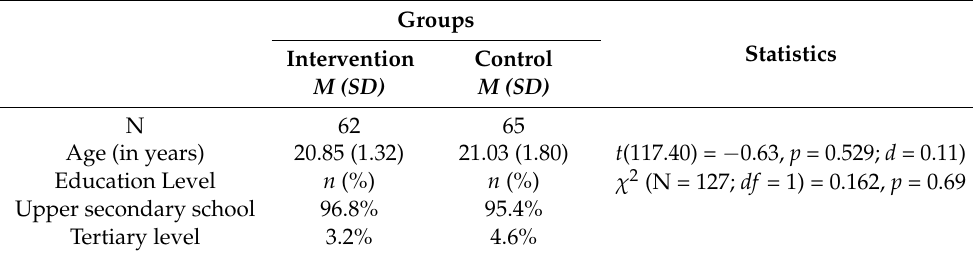
Table 1. Sample characteristic.